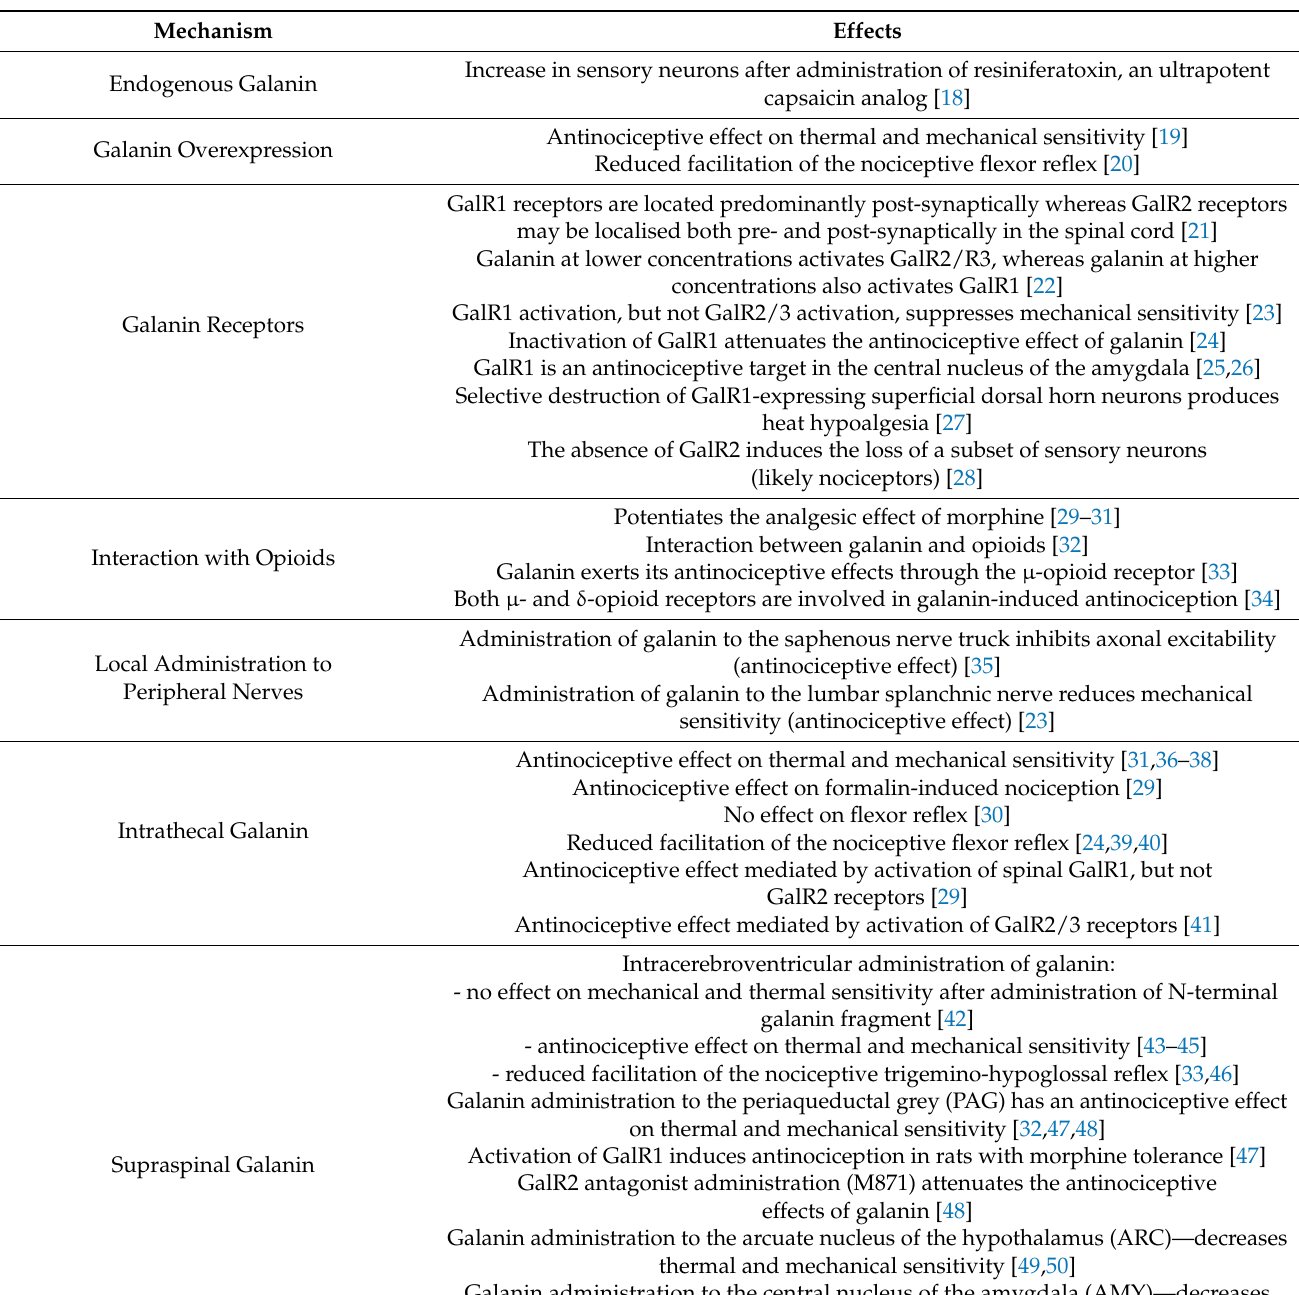
Table 1. Summary of the literature search on the role of galanin and its receptors in the processing of nociceptive